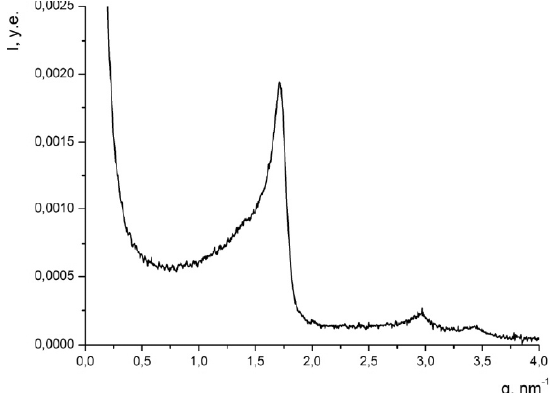
Fig. 1. Small angle X-Ray diffraction pattern of